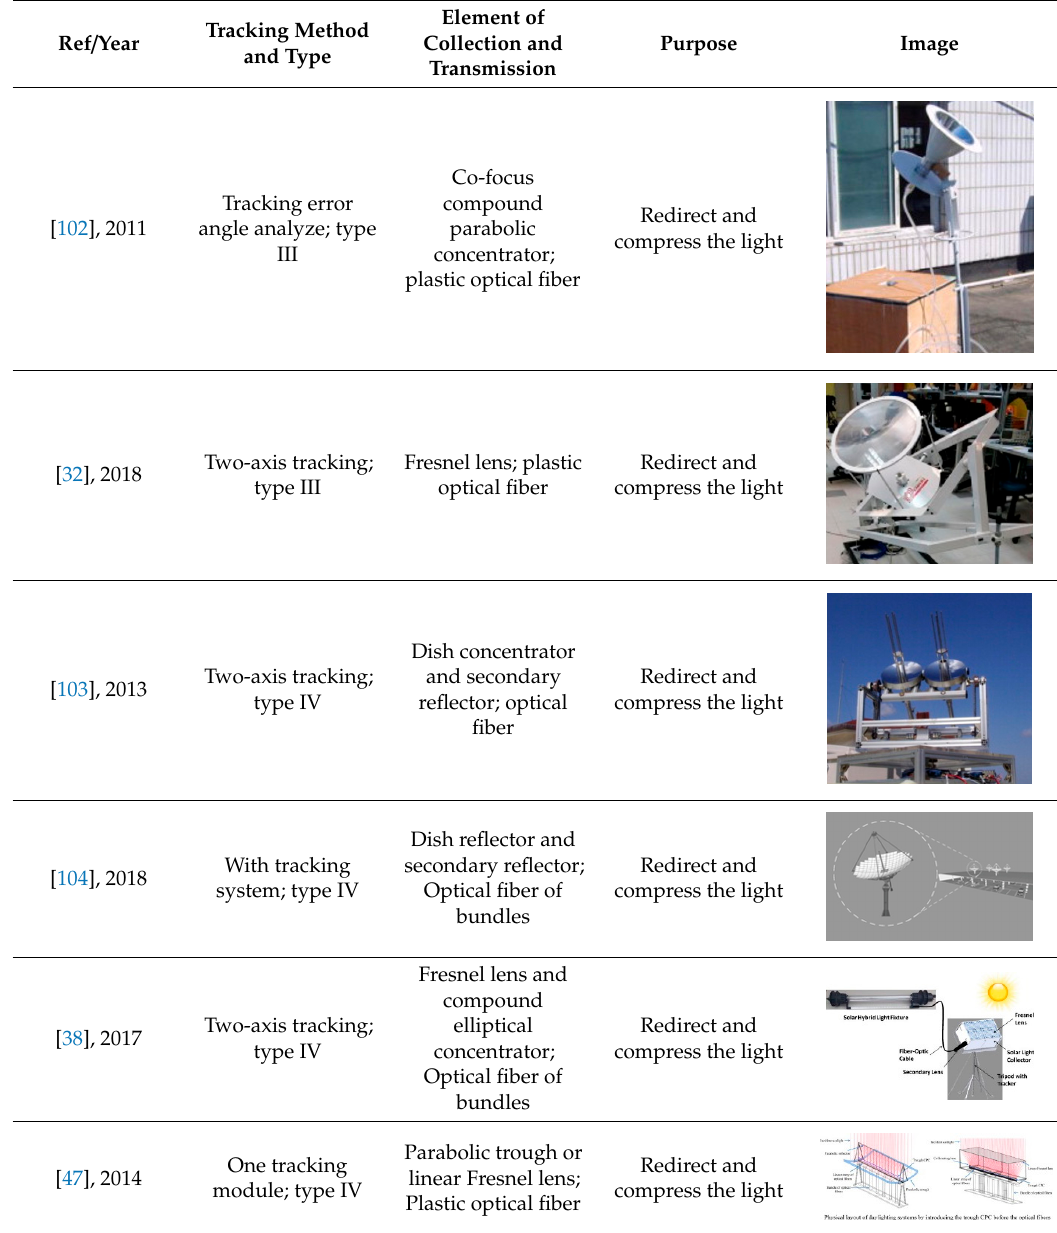
Table 6. Comparison of different characteristics between Plastic optical fiber (POF) and silica fiber [32].